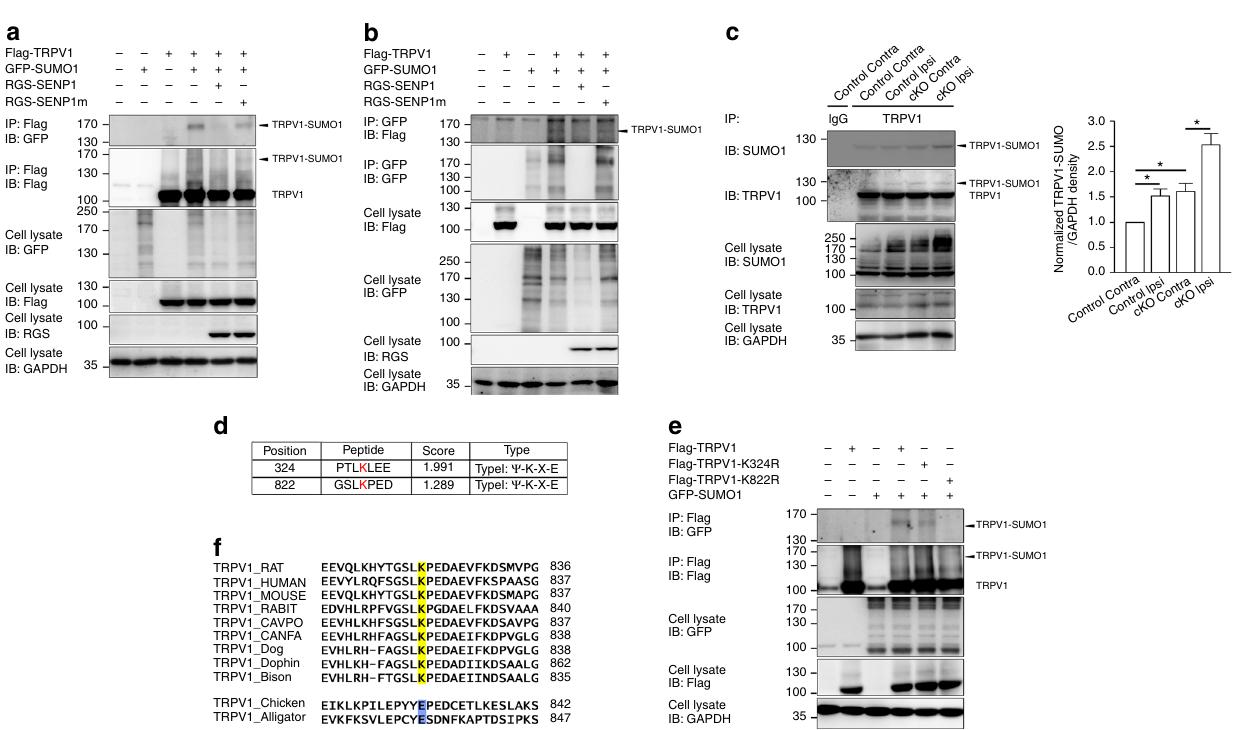
Fig. 4 SUMO1 modi fi cation of TRPV1. a Conjugation of TRPV1 by GFP-SUMO1 co-expressed in CHO-K1 cells. Cells were transiently co-transfected with the following plasmids as indicated: Flag-TRPV1, GFP-SUMO1, RGS-SENP1, and RGS-SENP1m. Cell lysates were immunoprecipitated (IP) with anti-Flag antibody and analyzed by immunoblotting (IB) using anti-GFP or anti-Flag. Whole-cell lysates were also used for IB with anti-GFP, anti-Flag, and anti-RGS antibodies for input. Molecular weight standards (in kD) are shown on the left. b Similar to a for reciprocal IP using anti-GFP (for GFP-SUMO1) and IB by anti-Flag (for Flag-TRPV1). c Increased TRPV1 SUMOylation in DRG from the ipsilateral side of carrageenan-injected hindpaw of SENP1 cKO mice. Carrageenan (2%, 20 μ l) was injected into the left hindpaw of SENP1 cKO and littermate control mice. L3 – L4 DRG were dissected from the ipsilateral (Ipsi) and contralateral (Contra) sides 1 h after the injection. Lysates of DRG isolated from littermate control (Control) and SENP1 cKO (cKO) mice were subjected to IP with a control IgG or an anti-TRPV1 antibody, which were followed by IB using anti-SUMO1 and anti-TRPV1 antibodies. Note the higher level of SUMOylated TRPV1 in the Ipsi than the Contra side and the higher levels in SENP1 cKO than Control. Quanti fi cation of western blots in c were determined by measuring the relative intensity of TRPV1-SUMO band and the corresponding GAPDH band from the same lysate, which was then compared with Control performed in parallel in the same experiment. Data shown are means ± s.e.m. for three experiments. P = 0.0211, Control Contra vs. Control Ipsi; P = 0.0180, Control Contra vs. cKO Contra; and P = 0.0274 cKO Contra vs. cKO Ipsi by Student ’ s t test. d Potential SUMO modi fi cation sites made by site-directed mutagenesis and co-expressed with GFP-SUMO1 as indicated. Cell lysates were subjected to IP by anti-Flag, followed by IB for GFP species shown in yellow. Note in chicken and alligator, the lysine is replaced by glutamate shown in blue. All blot images are representatives of